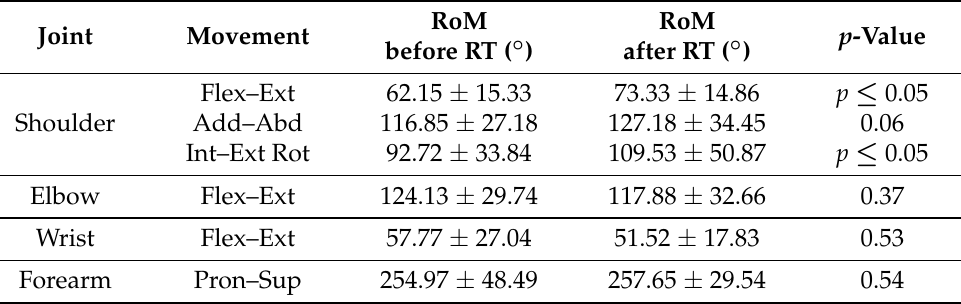
Table 4. RoM obtained for the paretic limb in the Maximum Forward Reach Test before and after the rehabilitation